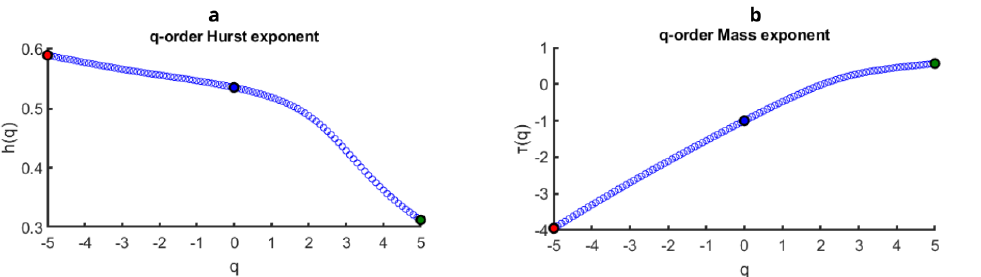
Figure 5. ( a ) Plot of h ( q ) on q and ( b ) plot of τ ( q ) on q .